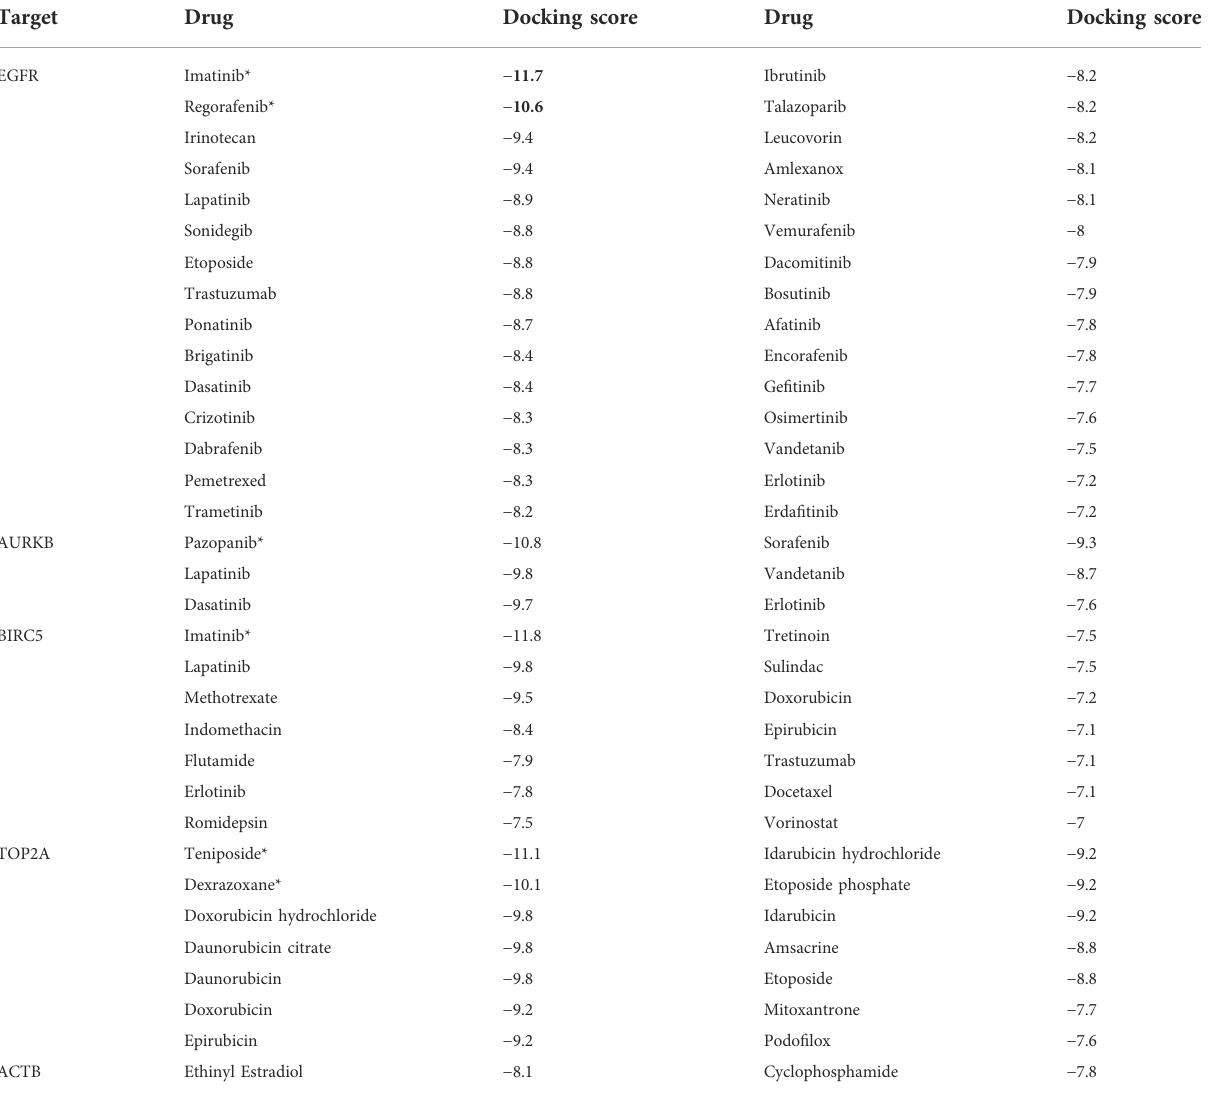
TABLE 3 List of drugs associated with corresponding targets, calculated binding af fi nity scores (BAS), and proposed candidate drugs highlighted by bold and star (*).